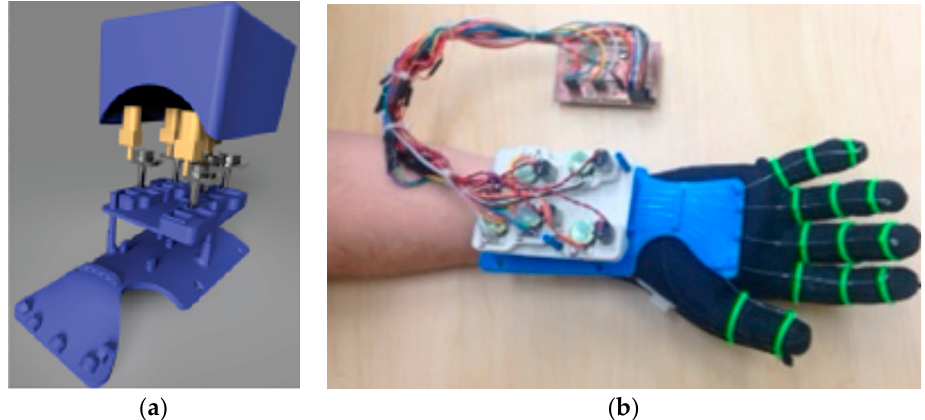
Figure 5. ( a ) Mechanical integration and ( b ) fully assembled robotic hand exoskeleton connected to the microcontroller via a wire harness (black—soft neoprene glove, blue—3D-printed ergonomic base, green—tendon connection points to linkages).